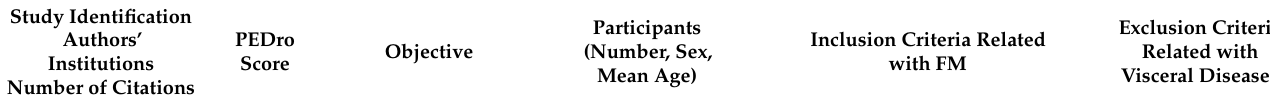
Table 3. Clinical trials evaluating the effects of physical therapy in FM fulfilling both criteria ( n =